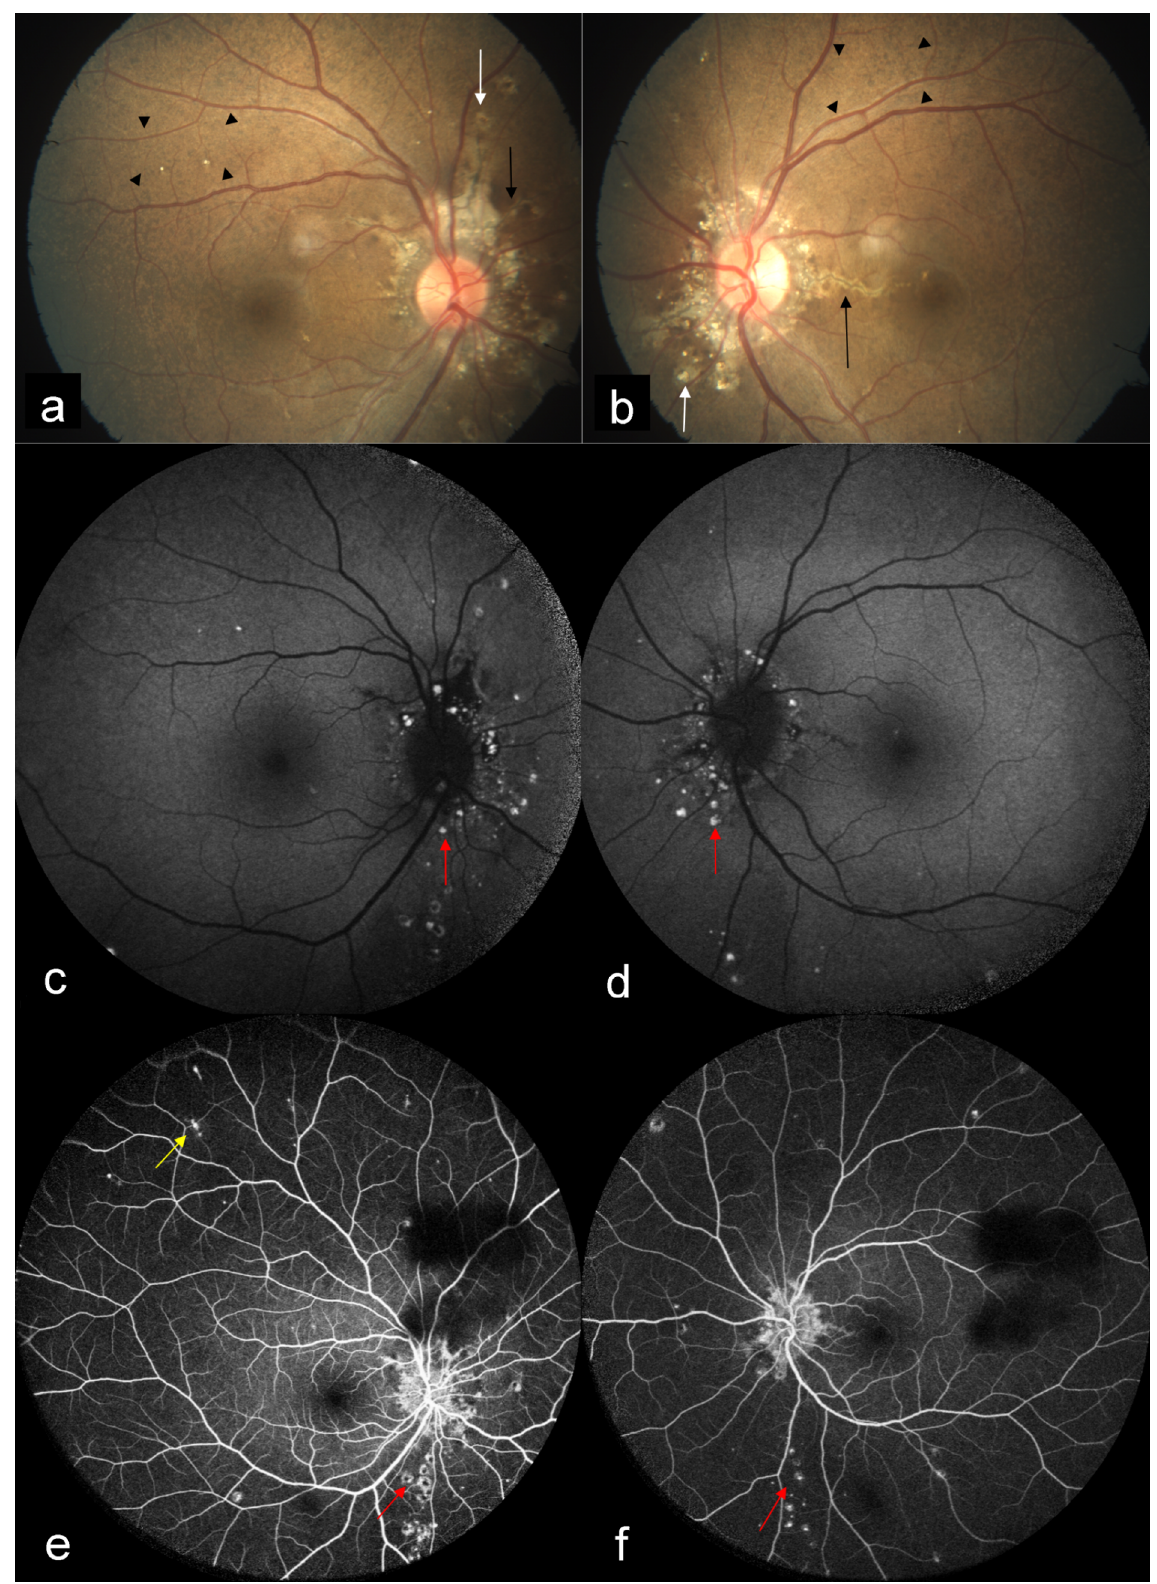
Figure 3: CFP (a, b) showed bilateral AS (black arrows) with peau d’orange as alternating dark and bright patches (arrow heads). Subretinal crystalline bodies and round white lesions without tails were seen surrounding the optic disc, suggestive of atypical drusen (white arrows). Spots of chorioretinal atrophy with variable size and “punched-out” appearance were seen in mid-periphery, suggestive of comet lesions. Comet lesions of both eyes showed a focal increased fundus autofluorescence (c, d) (red arrows) and a hyperfluorescence on late phase fundus fluorescein angiography (e and f) (red arrows). The associated comet tail that usually leaves the focal atrophy toward the posterior pole could be seen as hyperfluorescent in the right eye (e) (yellow